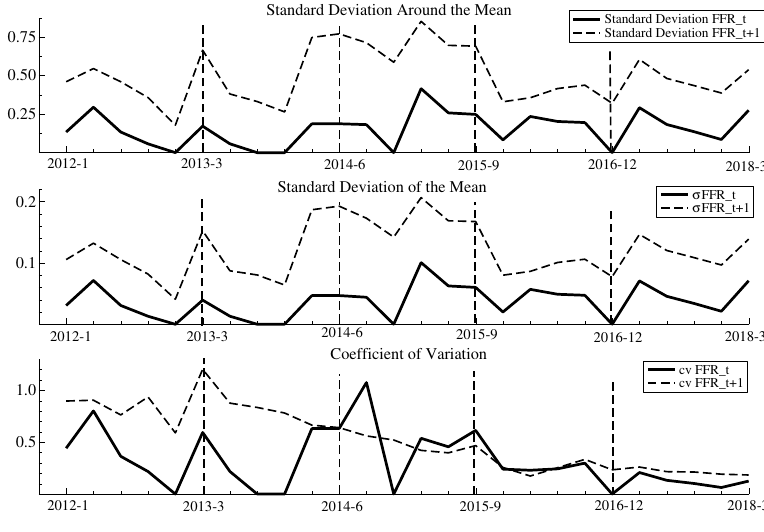
Figure 5. Dispersion of Appropriate Interest